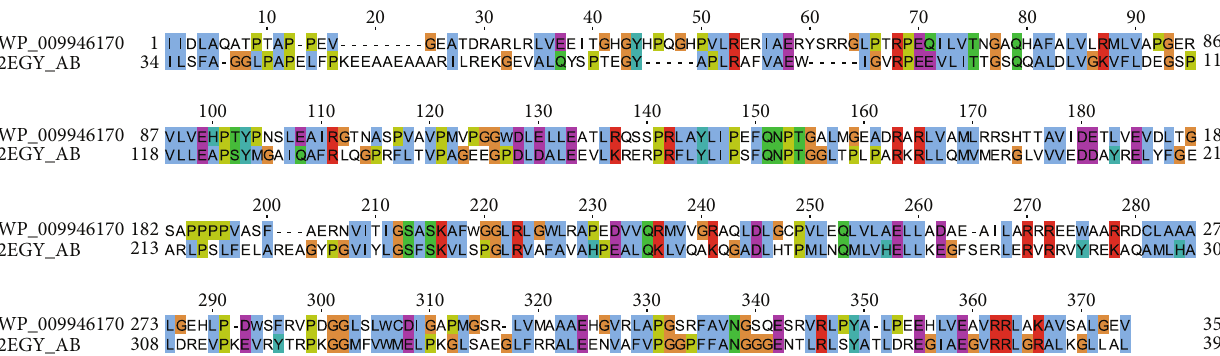
Figure 6: Sequence alignment between AAT domains for homology modelling. Sequence alignment between the AAT domains of the MocR from Saccharopolyspora erythraea (RefSeq code WP 009946170) and the template 𝛼 -aminoadipate aminotransferase from Thermus thermophilus (PDB code